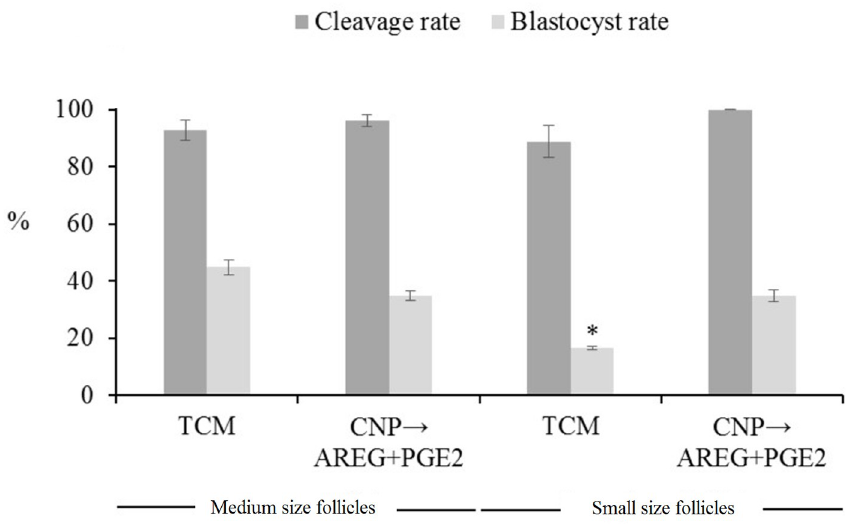
Fig 8. In vitro development of COCs derived from medium ( > 4 to 6 mm) compared to small (2 to � 4 mm) size follicles that cultured in TCM (control) or TCM+NP then cultured in TCM+AREG+PGE2 (treatment). 5 replicates and the minimum number of oocytes in each replicate were 50. The asterisks represent the significant difference for blastocyst rate in small size follicles. TCM: tissue culture medium, CNP: natriuretic peptide type C, AREG: amphiregulin, PGE2: prostaglandin